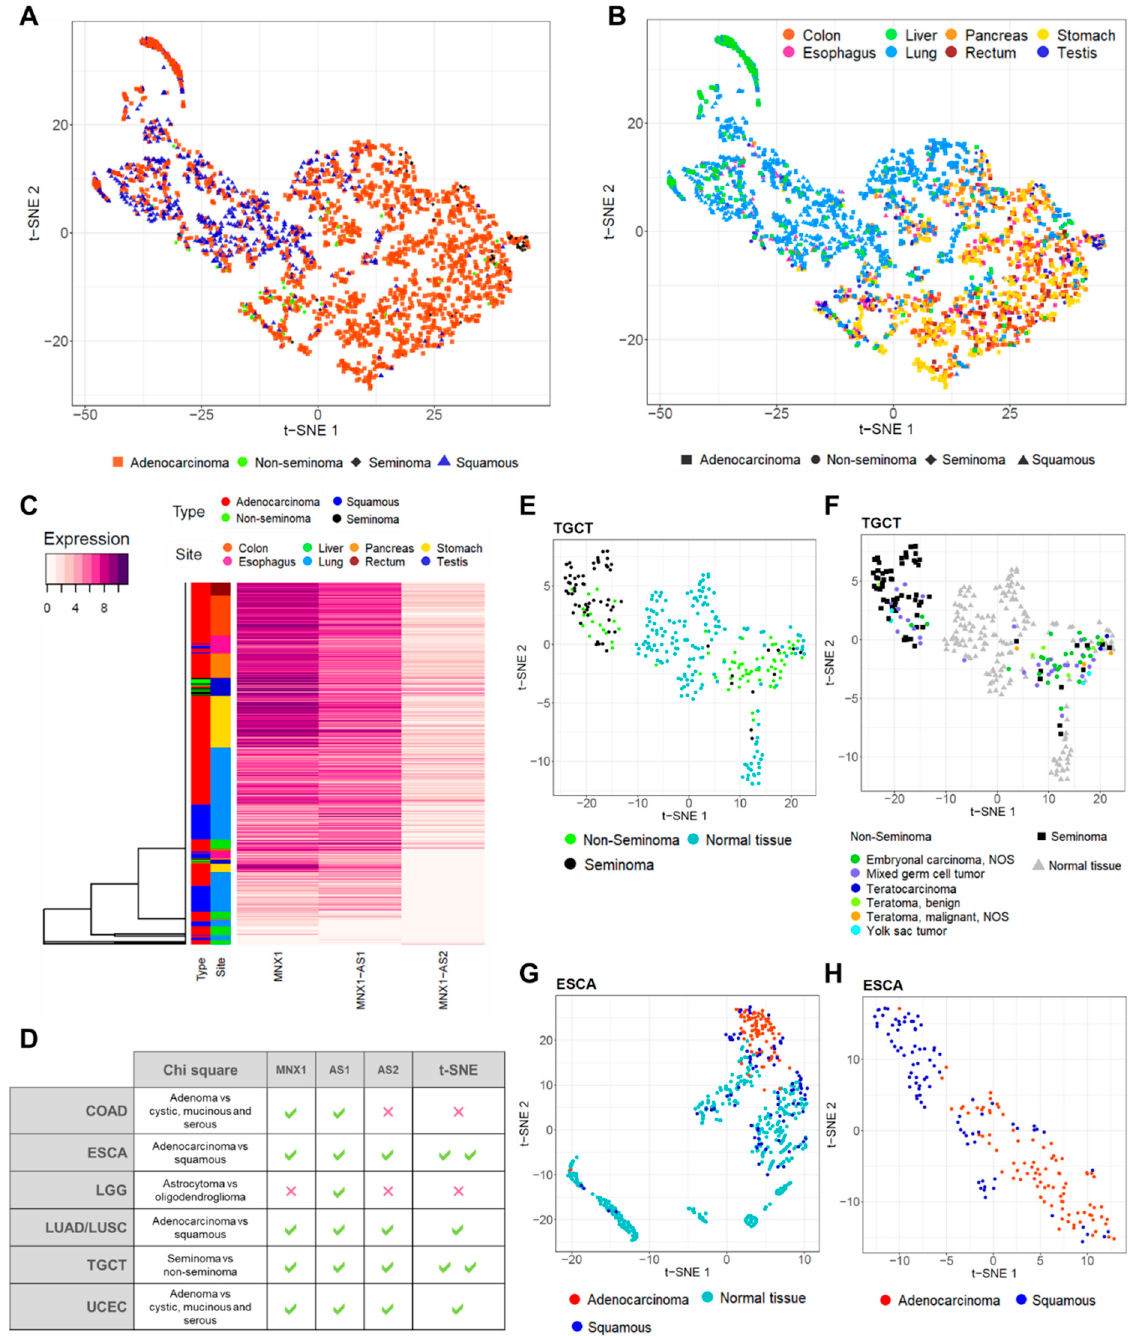
Figure 5. Site-specific t-SNE clustering for the identification of disease subtypes by combinatorial expressions of MNX1 , MNX1-AS1 , and MNX1-AS2 . ( A ) t-SNE visualisation of selected cancer sites by tumour type (adenocarcinoma, squamous, non-seminoma, and seminoma). ( B ) t-SNE clustering by tumour type and colour-coded by cancer site. ( C ) Hierarchical clustering of MNX1 , MNX1-AS1 , and MNX1-AS2 expression levels, with cancer type and site information, revealing similar clustering patterns to t-SNE analyses. ( D ) Comparison between Chi-square results of distinction between disease subtypes and the correspondence in t-SNE visualisation of distinct clusters. One green tick indicates a statistically significant correlation in Chi-square tests and the ability to differentiate disease subtypes using t-SNE. Two green ticks indicate a strong t-SNE clustering performance. ( E ) Site-specific t-SNE clustering of TGCT tumours against healthy testicular tissue (GTEx) by TGCT types of seminomas and non-seminomas. ( F ) Diagnostic subtype specification of samples within clusters identified using t-SNE in TGCT seminomas and non-seminomas. ( G ) t-SNE clustering of ESCA tumour subtypes (adenocarcinomas and squamous carcinomas) and healthy